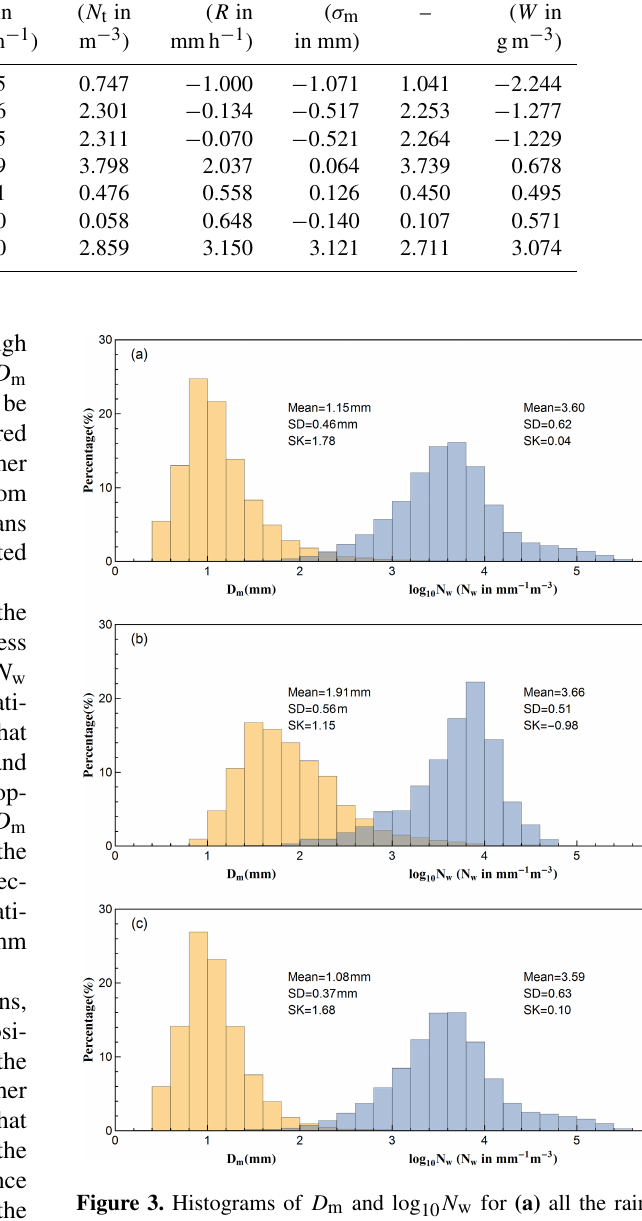
Figure 3. Histograms of D m and log 10 N w for (a) all the rainfall events, (b) convective events, and (c) stratiform events. Mean val- ues, standard deviation (SD), and skewness (SK) are also shown in the respective